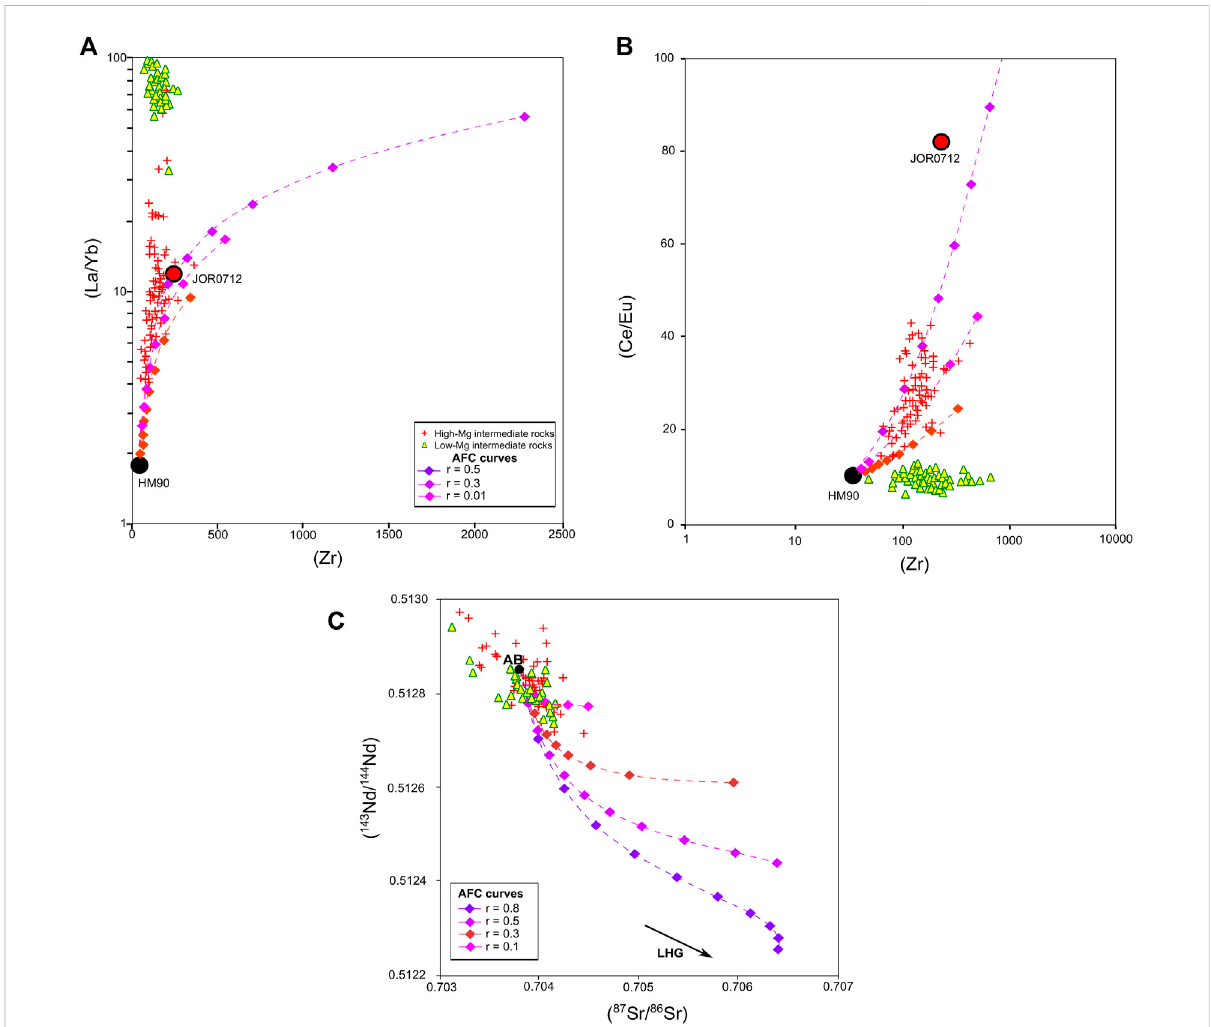
FIGURE 10 (A,B) Bivariate assimilation-fractional crystallization model for intermediate magmas from the MGVF. The intermediate magmas display high ratios of fractional crystallization and low ranges of assimilation between ma fi cmelt(HM90) and graniticcomponent (JOR0712; r ~=0.001 – 0.1). (C) Sr – Nd isotope assimilation and fractional crystallization model for intermediate magmas from the MGVF, which display ratios of assimilation between r = 0.1 and r = 0.3. The LHG samples were taken from Luhr and Carmichael, (1985b); Luhr,